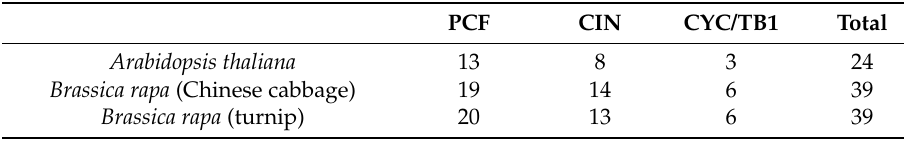
Table 2. TCP family genes in Arabidopsis thaliana , Chinese cabbage and turnip.